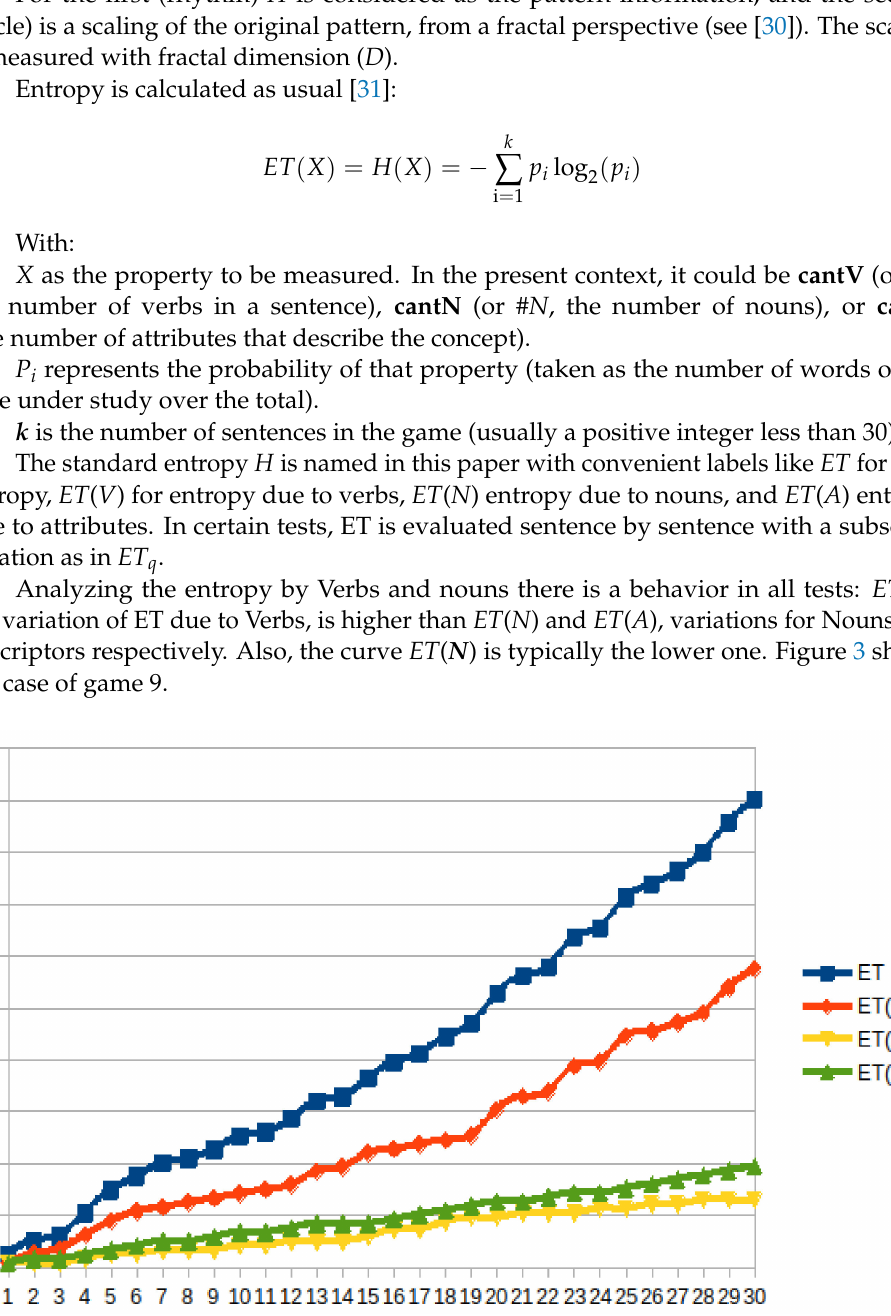
Figure 3. Entropy for game